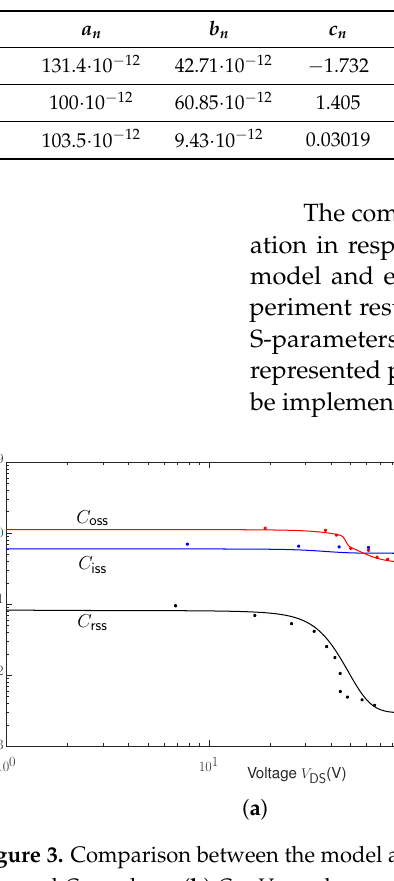
Table 2. Parameters used in Equation (2).